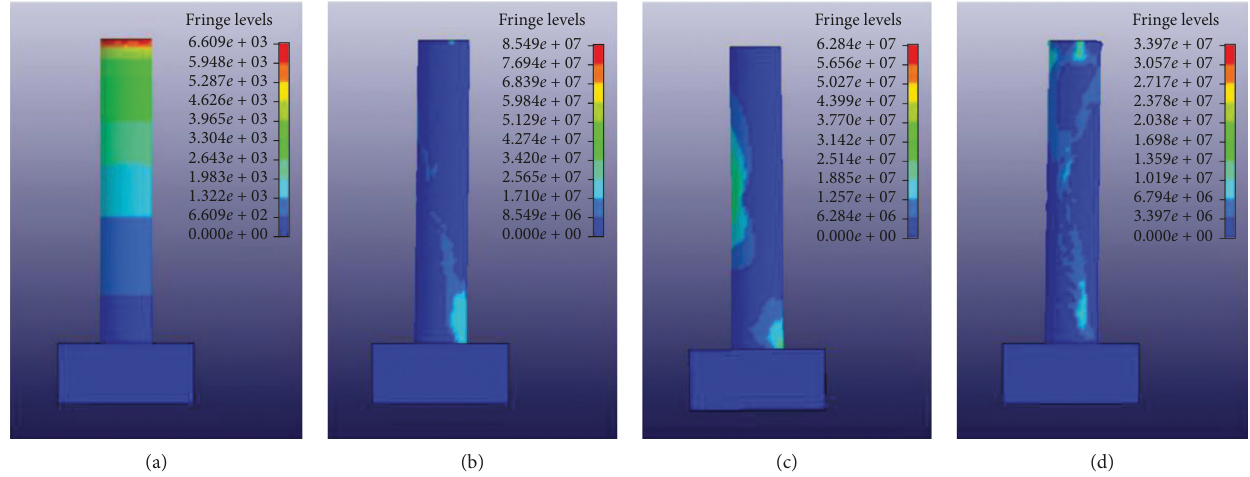
Figure 10: Stress nephogram of R2-8m (Unit: Pa): (a) R2-8 m ( T � 0.030s), (b) R2-8 m ( T � 0.035s), (c) R2-8 m ( T � 0.062s), and (d) R2-8 m ( T �